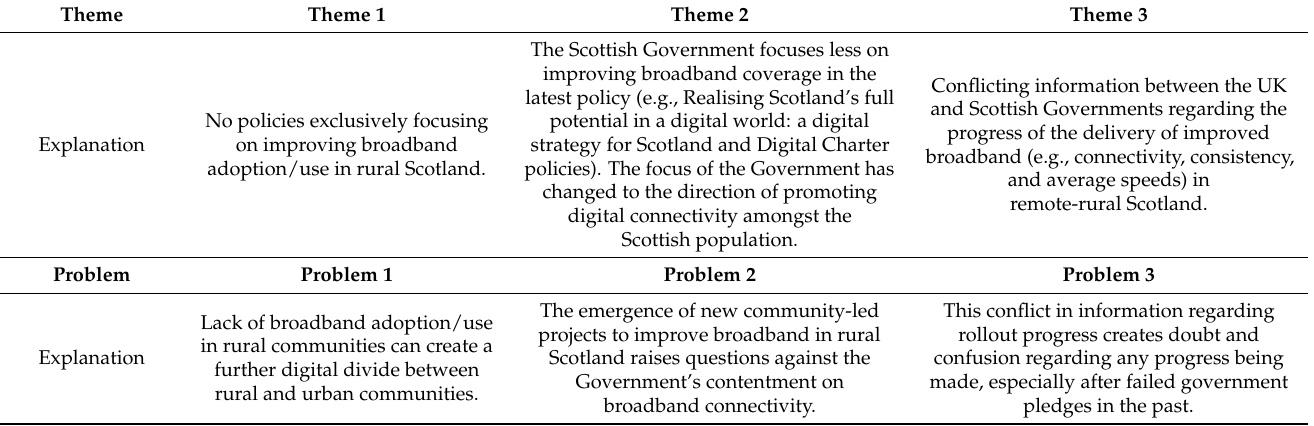
Table 5. Themes and problems emerge from the Policy Analysis (January 2006–May